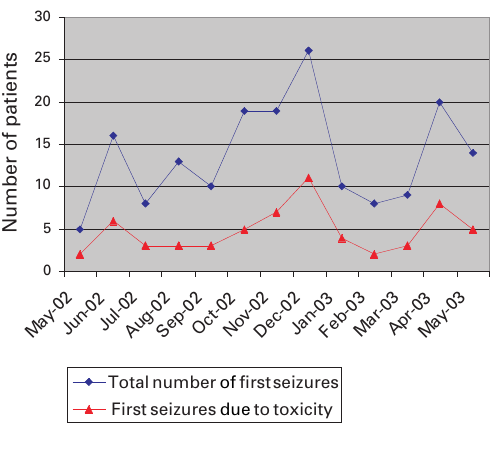
Occurrence of first seizures during the period of study.